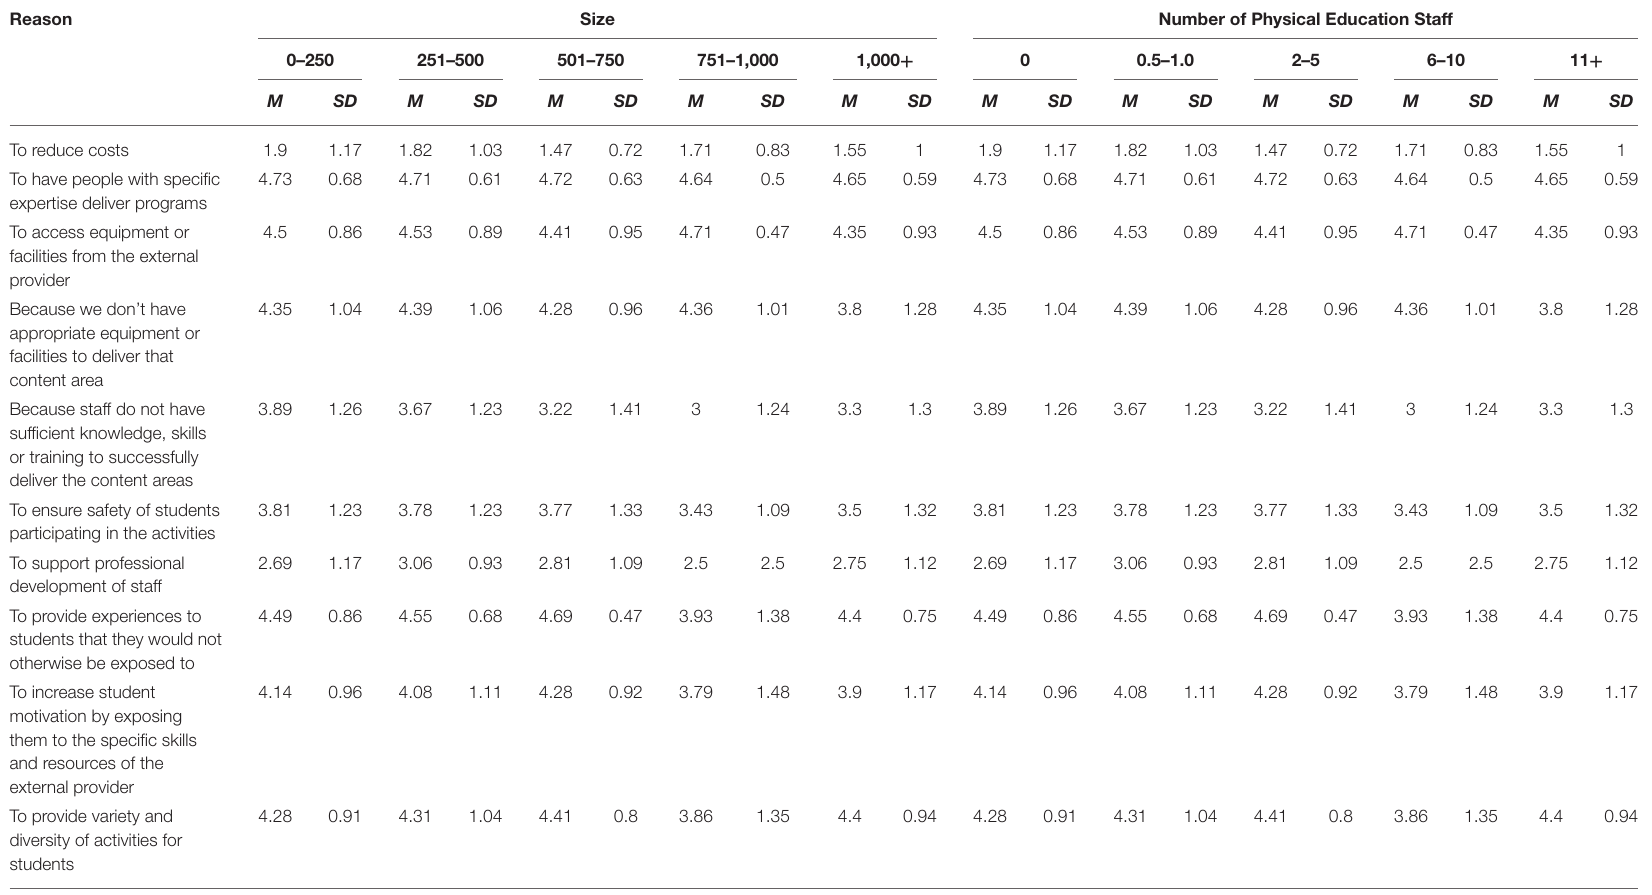
TABLE 4B | Reasons for outsourcing activities to external providers by size of school.